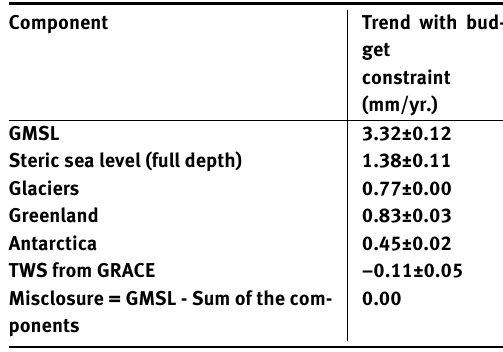
Table 1. Rigorously adjusted GMSL budget component